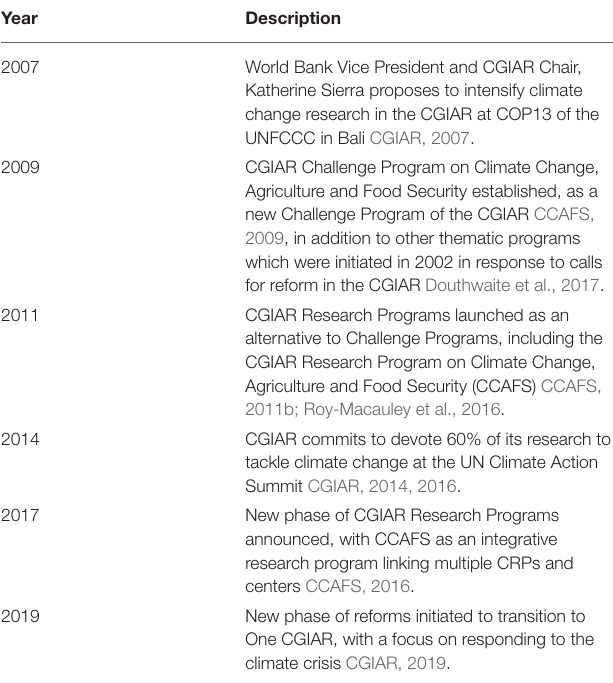
TABLE 1 | Evolution of climate change through reforms in the